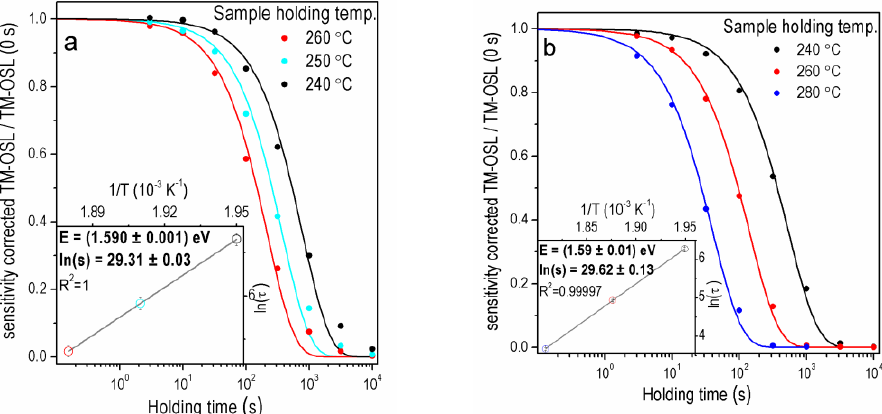
Figure 5. The OTDCs of the quartz samples ( a ) 2 MV 570A for dose 1000 Gy, FOM 240 = 1.57%, FOM 260 = 1.53%, FOM 280 = 2.99%, ( b ) MR for dose 100 Gy, FOM 240 = 1.17%, FOM 260 = 1.65%, FOM 280 = 2.98% for one aliquot and preheating 280 °C.